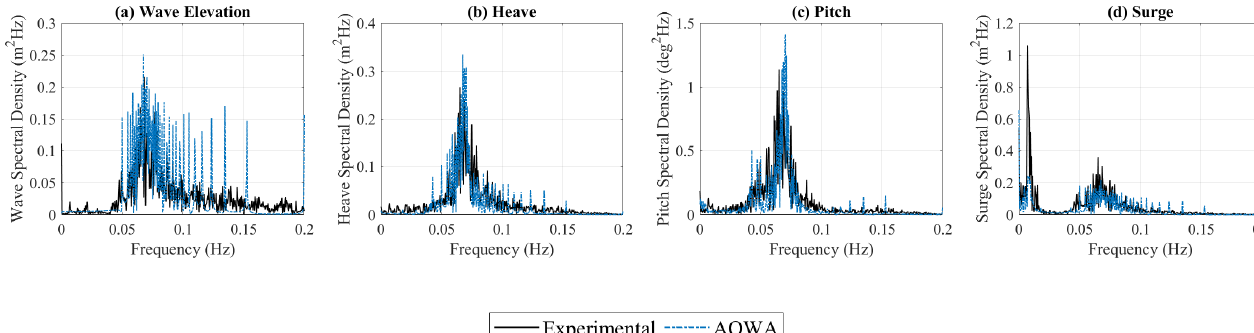
Figure 10. Experimental and numerical results for an elevated, irregular sea state ( H s = 3.384 m, T p = 14.598 s): ( a ) wave spectral density, ( b ) heave spectral density, ( c ) pitch spectral density, and ( d ) surge spectral density.